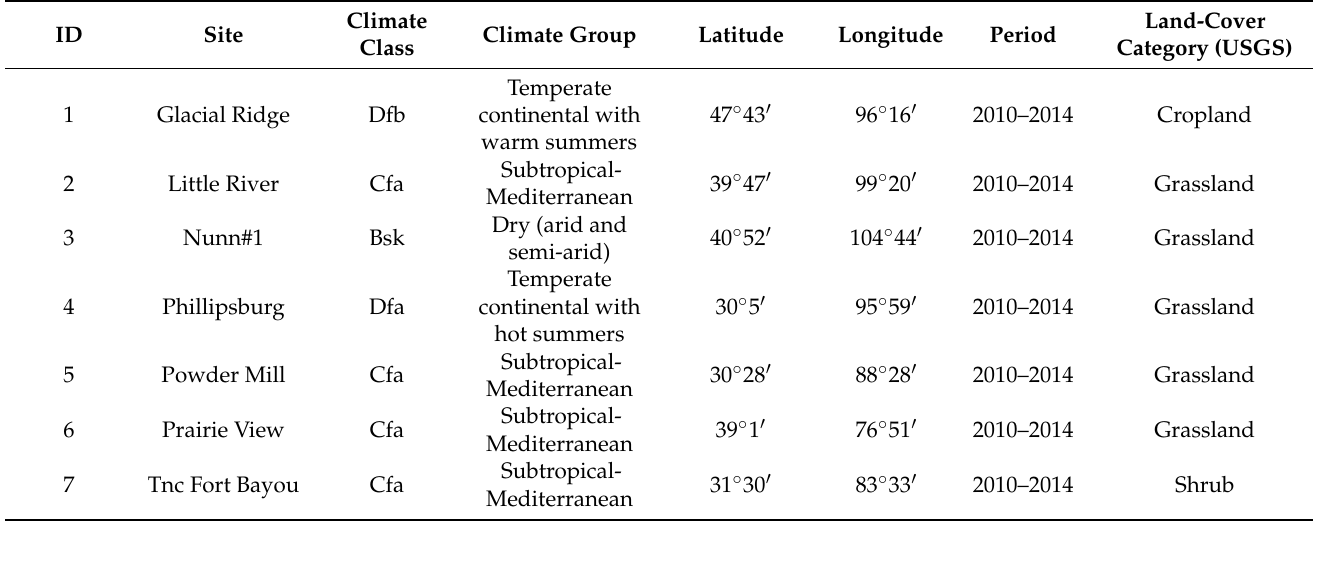
Table 1. Selected SCAN sites’ information and climatology. Climate class and climate group are defined according to Köppen climate classification [30]. Land cover types are defined by USGS classification [31].